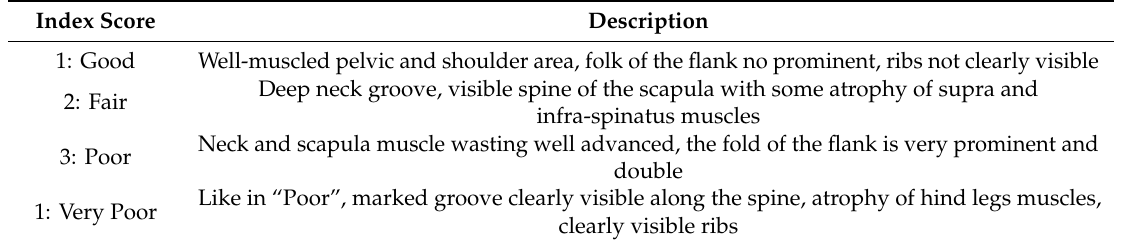
Table 1. System of scoring body condition of white rhinos based on the criteria described by Keep (1971). Index